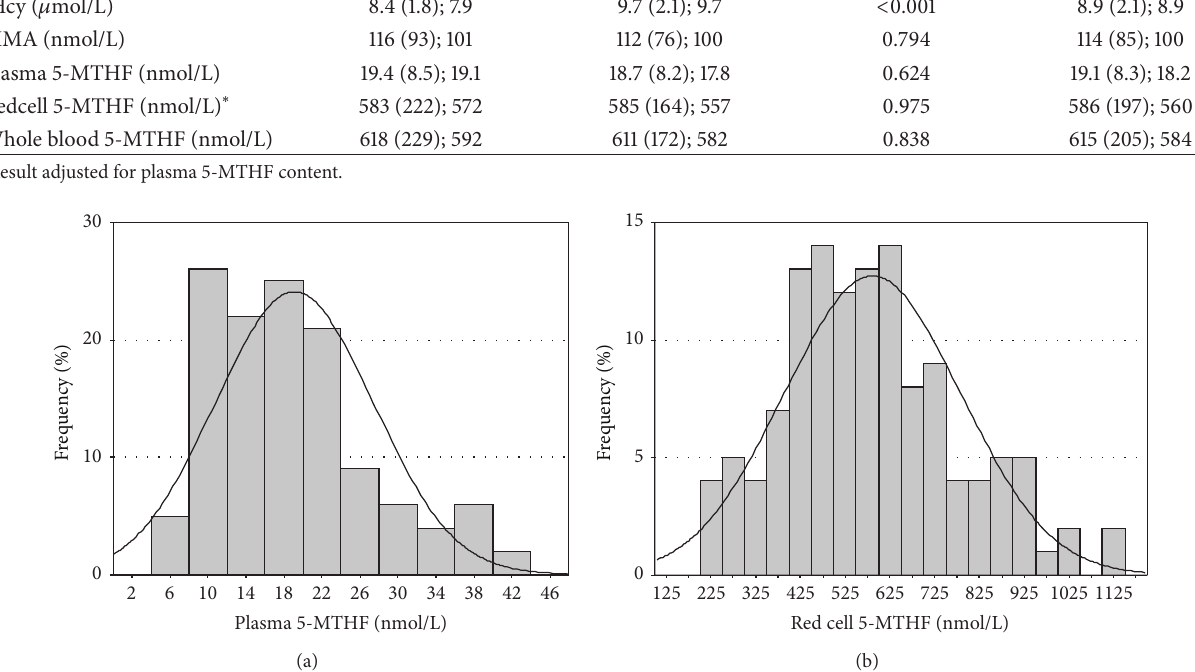
Figure 2: Distribution of the 5-MTHF concentrations in plasma and red cells. Table 2: Reference intervals for 5-MTHF with 90% confidence intervals for lower and upper 95% reference